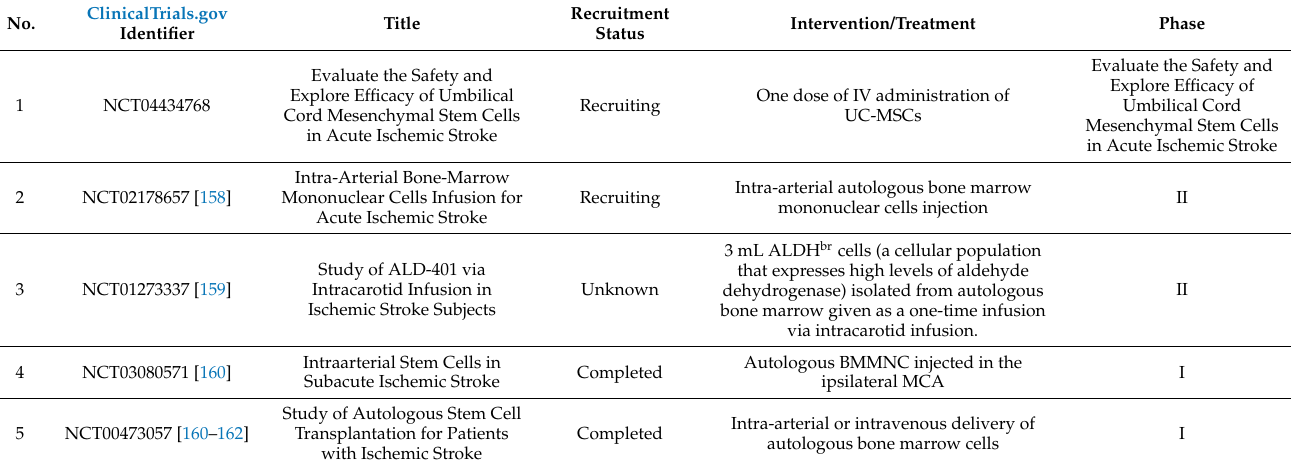
Table 2. Clinical trials of IA MSC infusion in